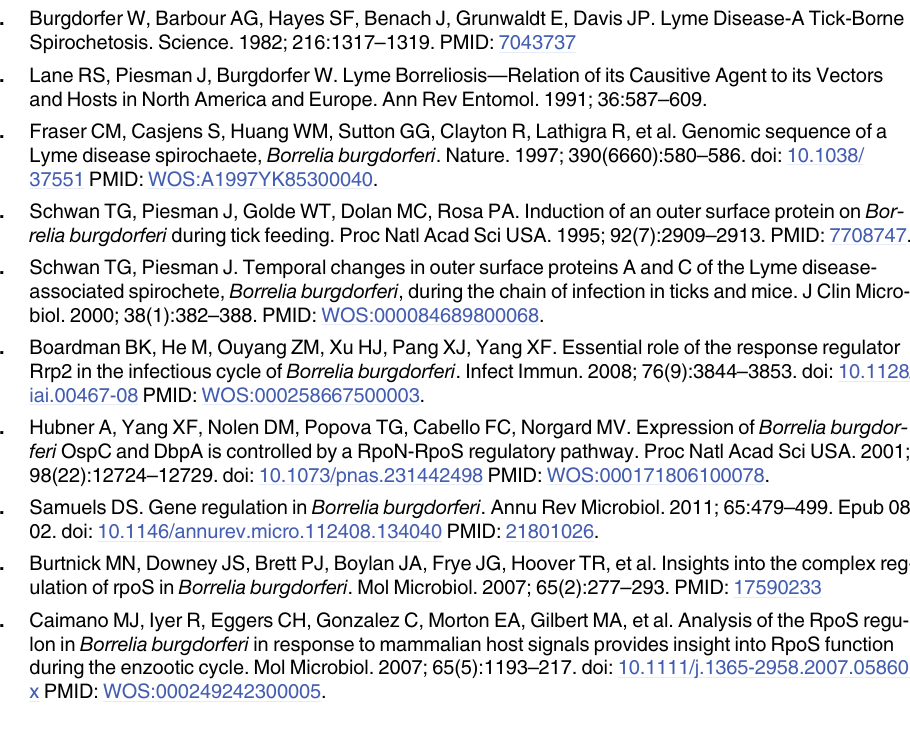
S1 Fig. Effect of acetate on growth of B . burgdorferi . (A) Growth of B31-A3 and (B) Δ ackA , respectively in the presence of 0, 30, and 60 mM exogenously added sodium